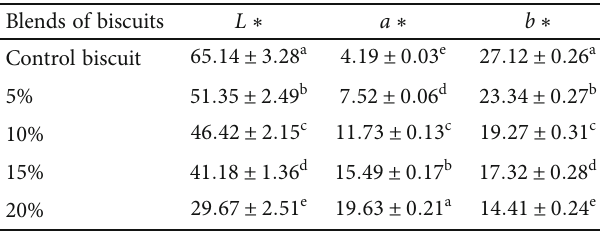
Table 5: Color in di ff erent blends of